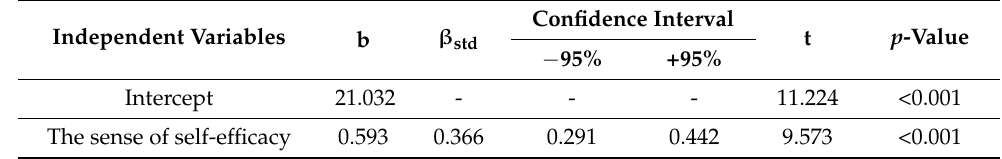
Table 3. The influence of the sense of one’s own efficacy on perfectionism.